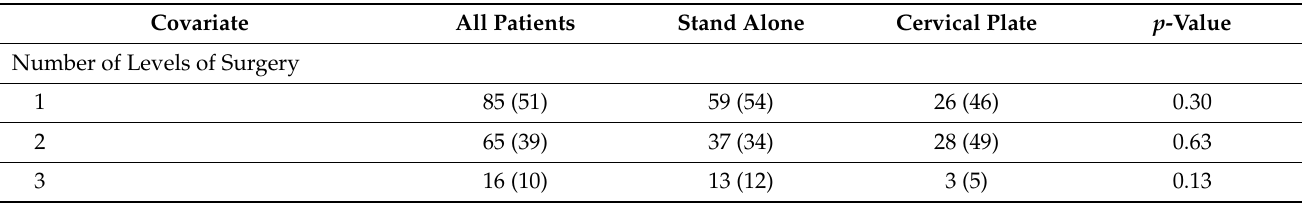
Table 2. Surgical